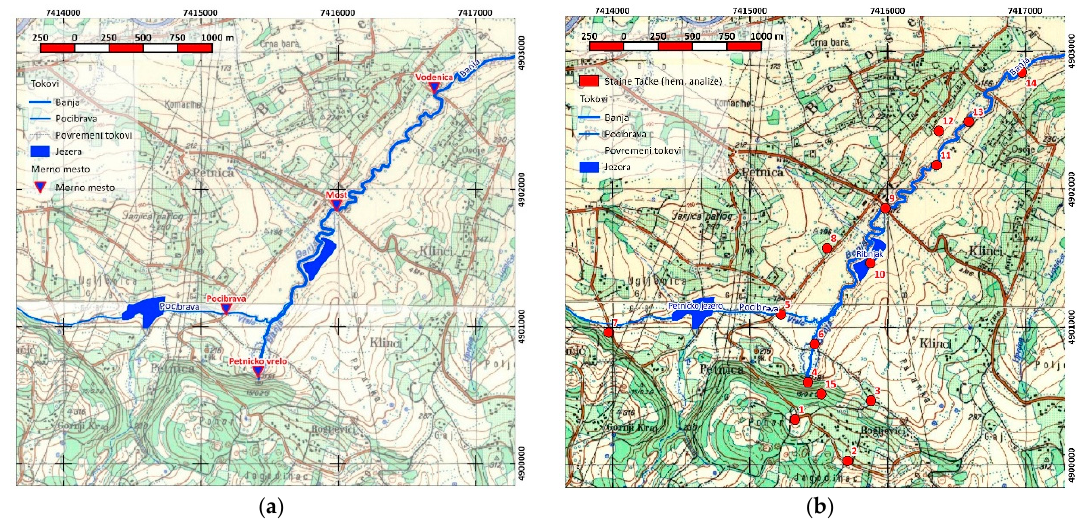
Figure 2. ( a ) Locations of monitoring points for measurements of flow on research area; ( b ) Locations of sampling points for chemical analysis on research